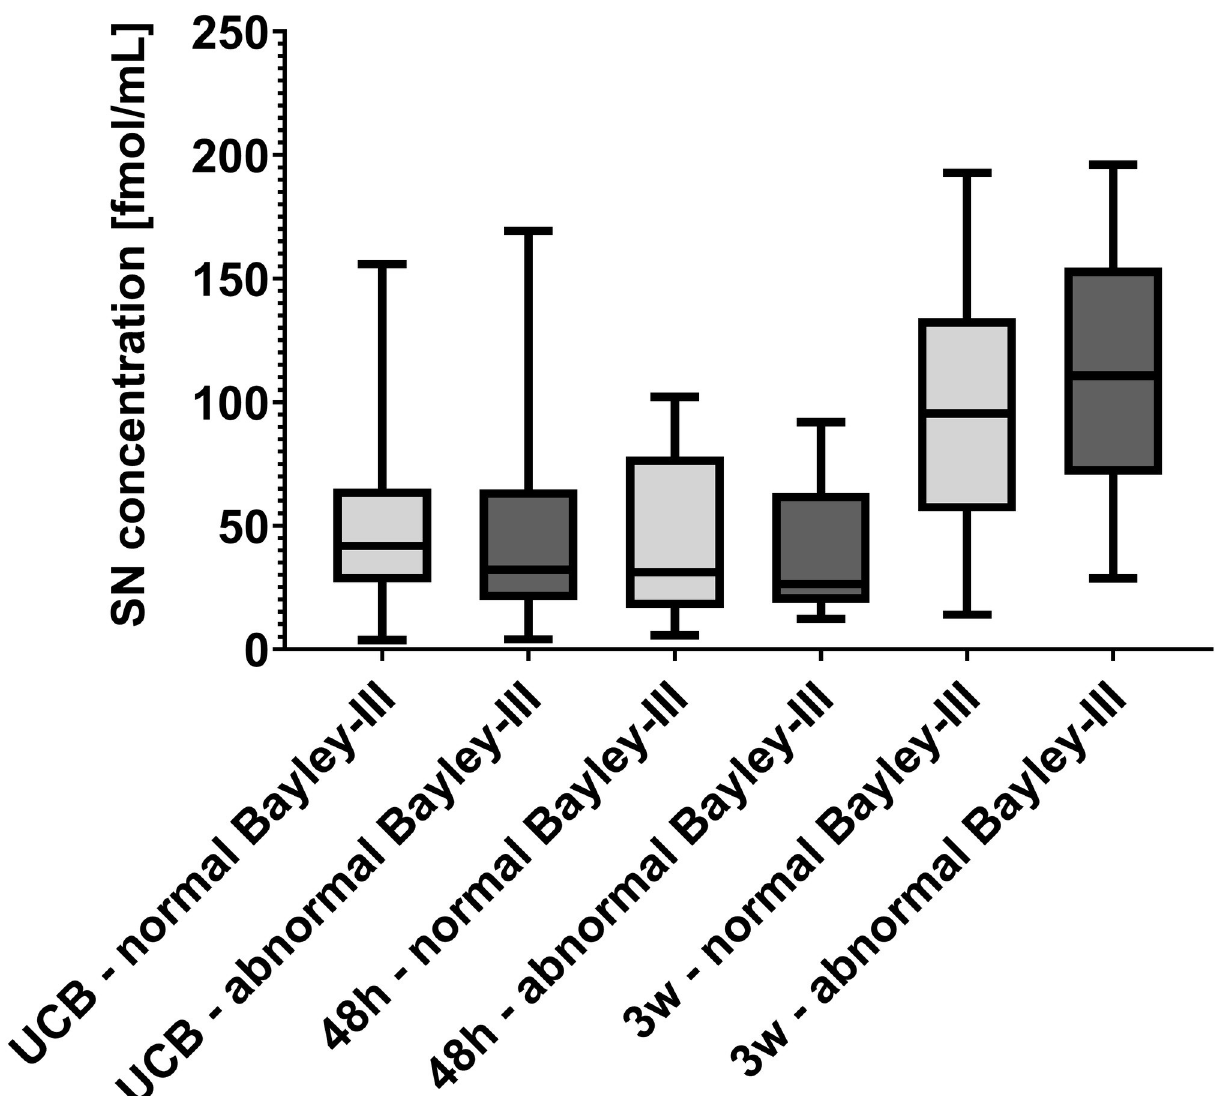
Fig 5. Secretoneurin (SN) levels in preterm infants with unfavourable outcome at the age of 2 years corrected age. No significant differences were detected in SN serum concentrations determined in umbilical cord blood (UCB) and in patient blood samples obtained at 48 hours (48h) and three weeks (3w) of life in preterm infants with abnormal neurodevelopmental outcome defined as a score of < 85 in any of the three major domains of the Bayley Scales of Infant and Toddler Development, third edition (Bayley-III). Number of samples analysed per group and time point: UCB–normal Bayley-III n = 15, UCB–abnormal Bayley-III n = 11, 48h –normal Bayley-III n = 14, 48h –abnormal Bayley-III n = 9, 3w –normal Bayley-III n = 17, 3w – abnormal Bayley-III n = 10. SN concentrations are depicted in fmol/mL. Centre lines in boxes represent medians, box edges mark 1st and 3rd quartiles, and whiskers indicate 5th and 95th